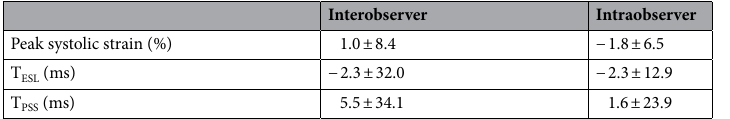
Table 5. Mean differences and limits of agreement (± 1.96 standard deviation) in interobserver and intraobserver measurements for peak systolic strain, T ESL , and T PSS in the apical anterior